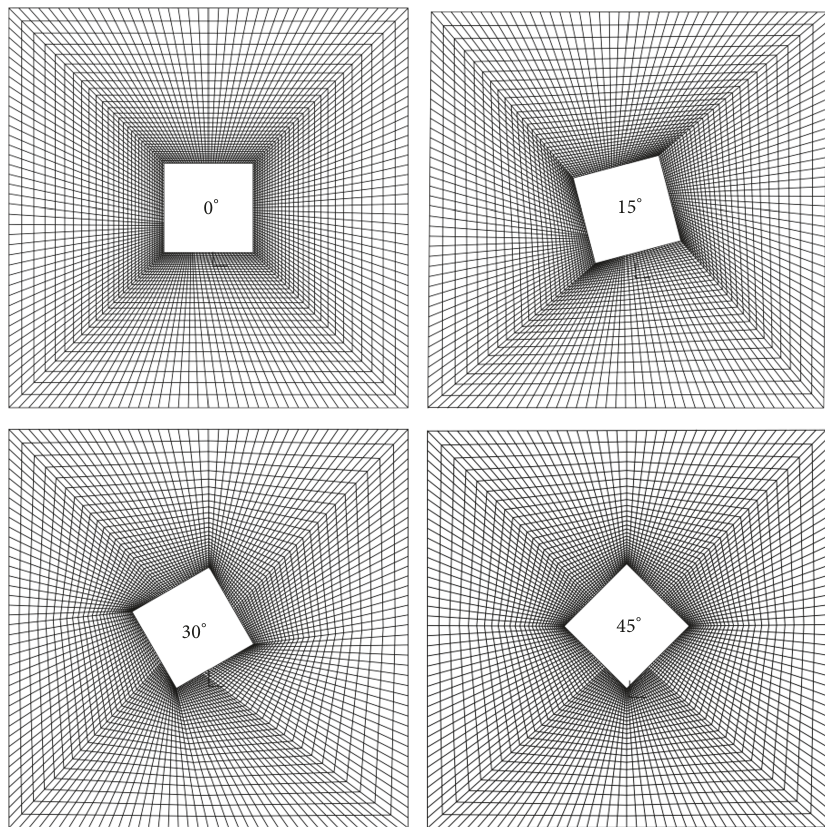
Figure 7: Mesh generation under different wind